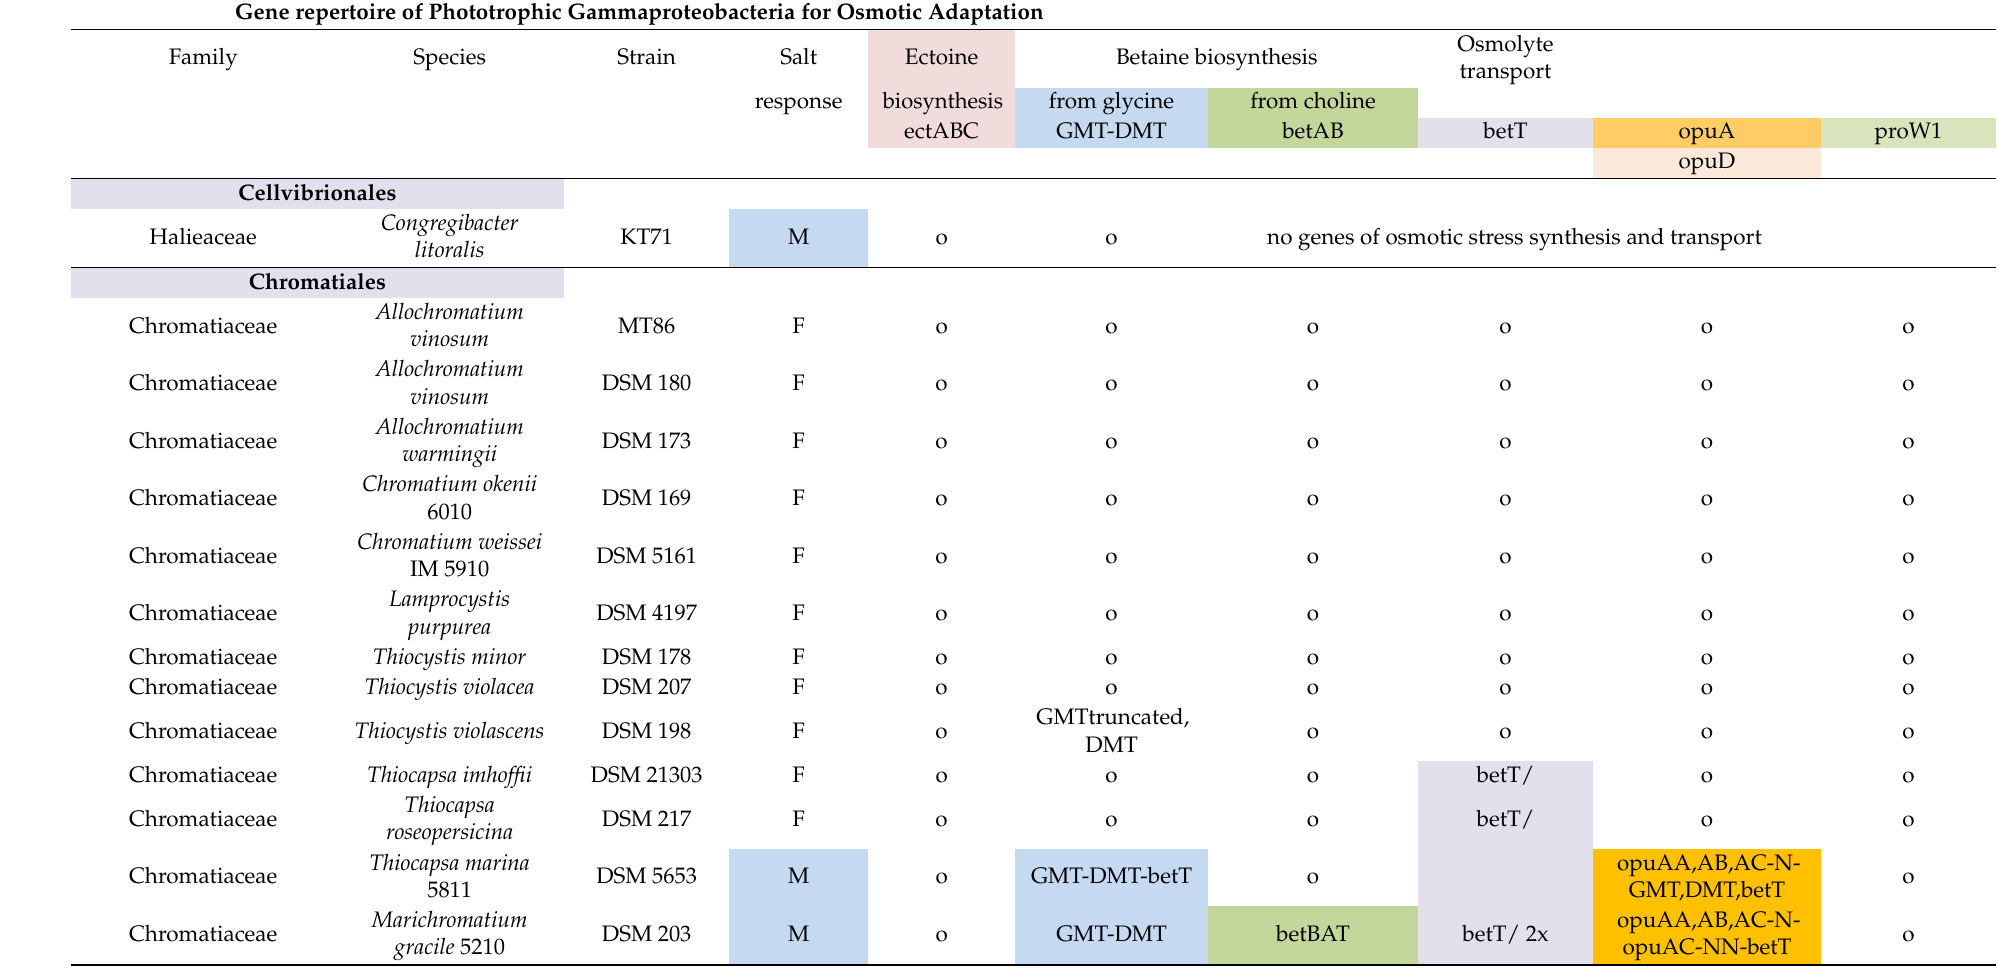
Table 3. Genes and gene clusters of betaine and ectoine biosynthesis as well as relevant transport systems of phototrophic Gammaproteobacteria a,b . Gene repertoire of Phototrophic Gammaproteobacteria for Osmotic